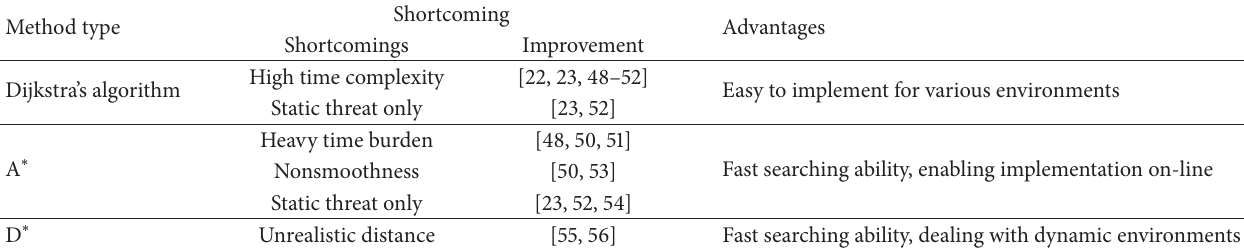
Table 3: Analysis of node based optimal